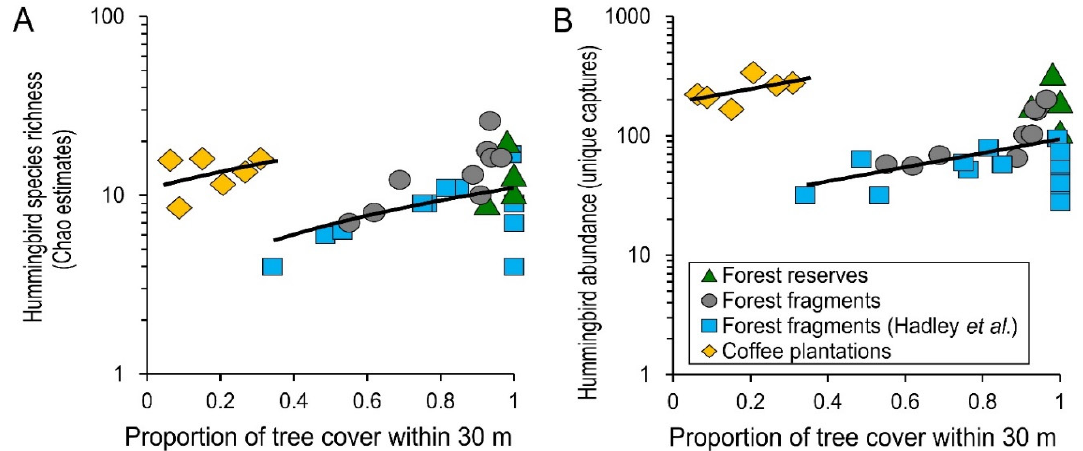
Figure 1. The number of hummingbird species in the agricultural ecosystem was related to the proportion of tree cover within 30 m of mist nets at each site, with a binary factor in the linear model separating coffee plantations from forest sites resulting in different y-intercepts in log space. Spatial scale was determined using a multiscale analysis to identify the scale of effect ( A ). Hummingbird abundance also followed a similar pattern, where tree cover within 30 m of mist nets at each site determined slope. Site identity as a coffee plantation or a forest again resulted in a significant difference in the y-intercept of the model in log space ( B ).